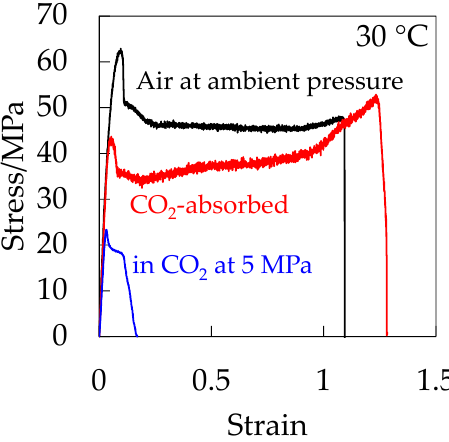
Figure 12. Stress–strain curve of OD-PC under air at atmospheric pressure in CO 2 at 5 MPa and CO 2 -absorbed PC under air at atmospheric pressure after absorbing and releasing CO 2 of 5 MPa.